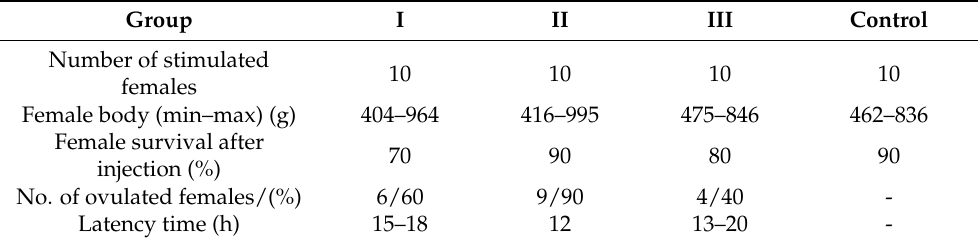
Table 3. Effects of different hormonal agents on blue bream Ballerus ballerus (L.) female ovulation during controlled reproduction.